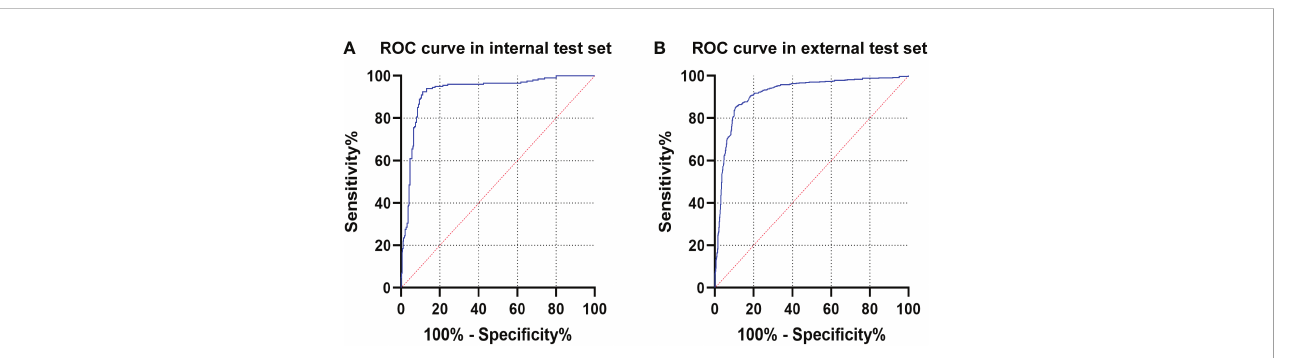
FIGURE 4 The ROC curve of CNN1 in the test sets. (A) ROC curve of CNN1 in the internal test set. (B) ROC curve of CNN1 in the external test set. ROC, receiver operating characteristic; CNN, convolutional neural